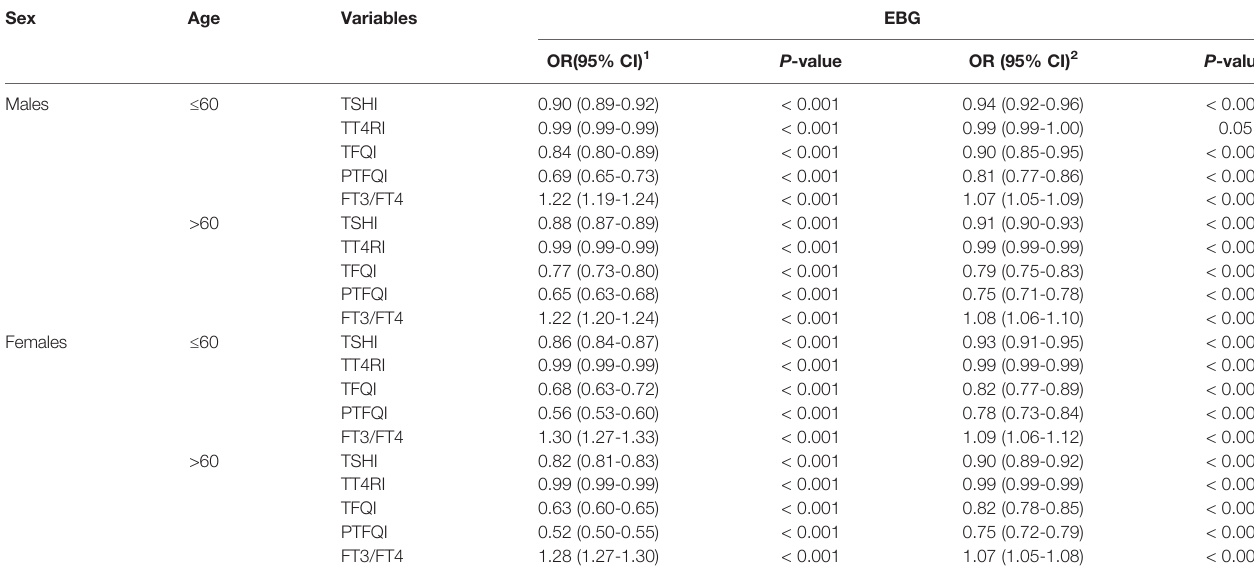
TABLE 5 | Relationship between thyroid hormone sensitivity and EBG in different sexes and different ages.